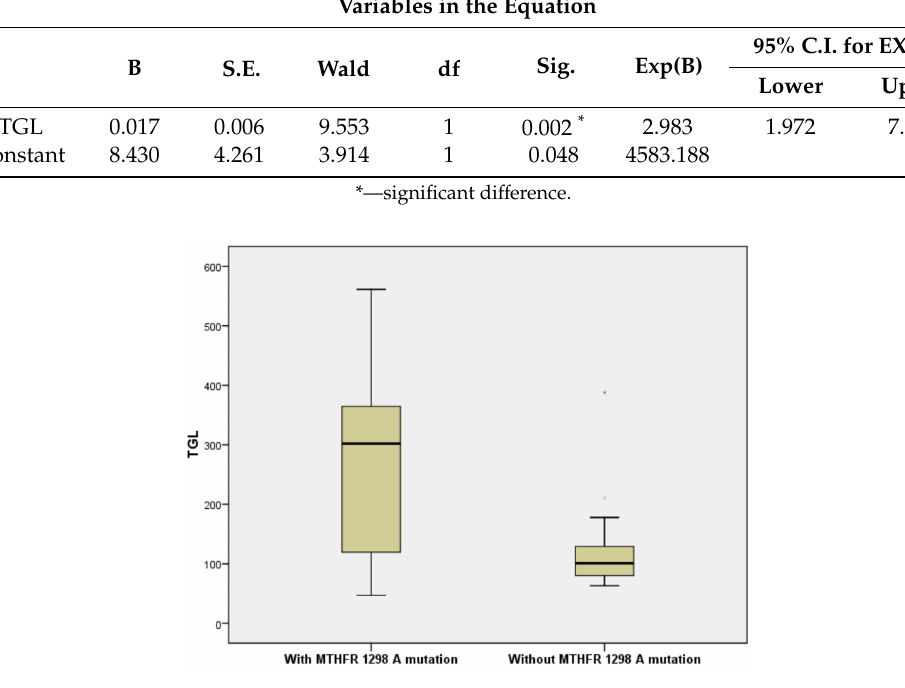
Figure 4. MTHFR A1298C is associated with a risk for high triglycerides (TGL) values (OR = 2.983, 95%CI = (1.972, 7.994)).